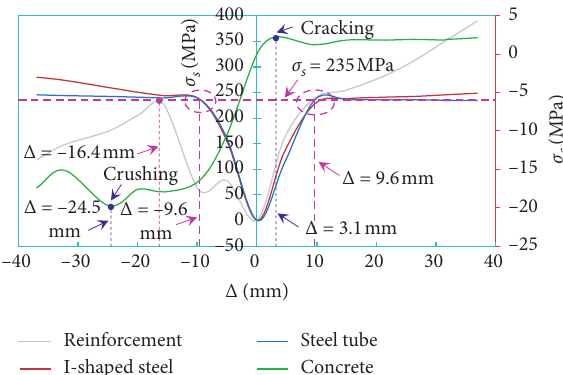
Figure 11: Stress development process of components.